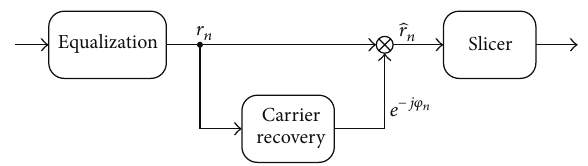
Figure 1: Simplified block diagram of the coherent receiver with